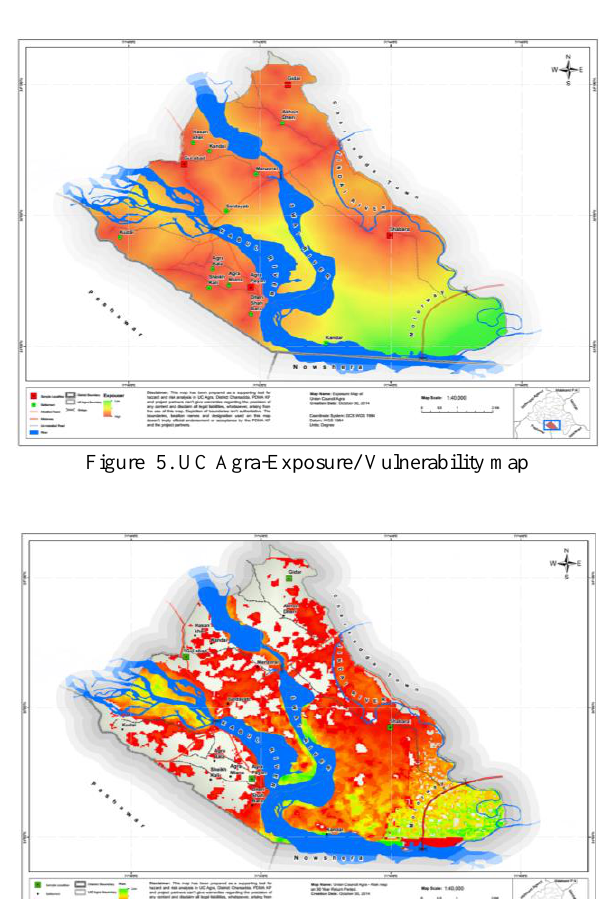
Figure 4. UC Agra - 2010 flood inundation map